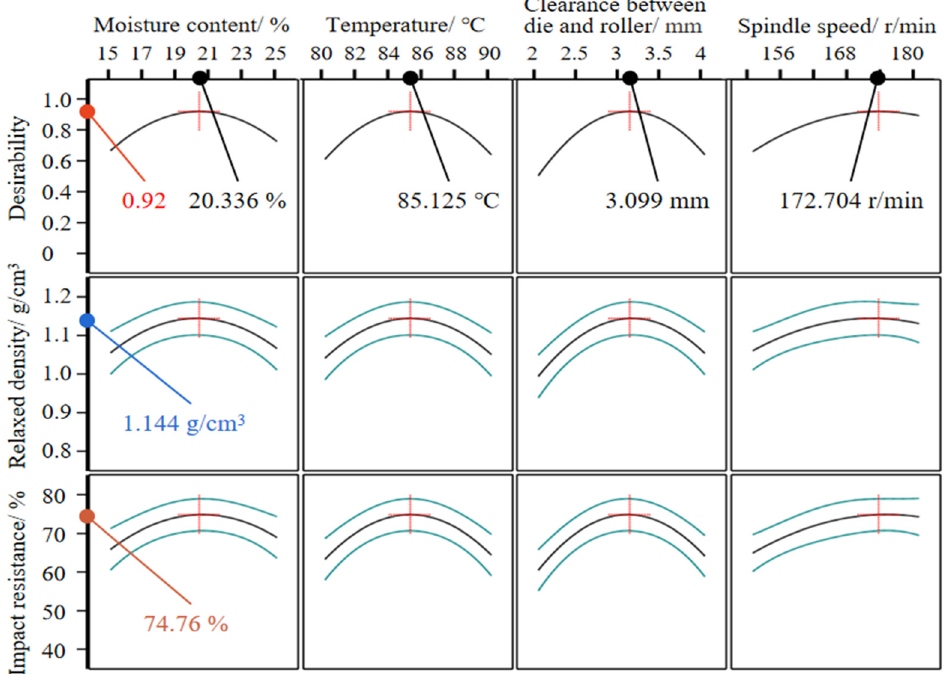
Figure 9. The result of the optimization of the Design-Expert software.